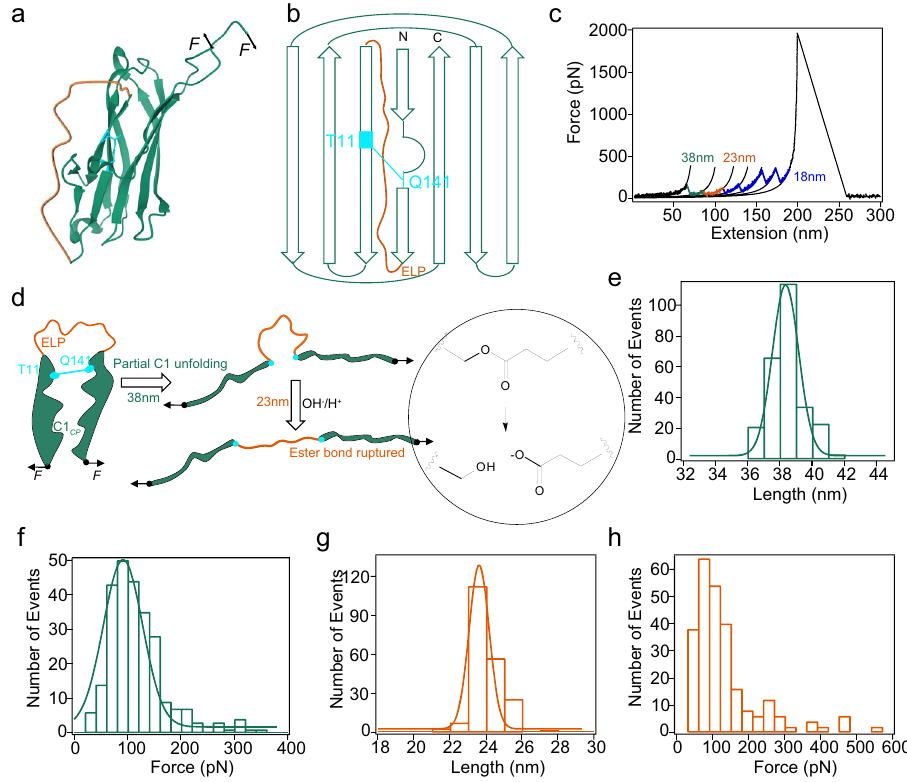
Fig. 3 Mechanical unfolding of the circular permutant of C1, C1 CP . a Structure of C1 CP based on PDB (4MKM). b Topology of C1 CP . Ester bond formed between T11 and Q141 is highlighted in cyan. The new N- and C-termini are at the position 126 and 125, respectively. The original N- and C-termini are connected by an ELP loop. c Representative force – extension curve of stretching (GB1) 2 -C1 CP -(GB1) 2 following the same experimental protocol shown in Fig. 1d. The force peaks with Δ L c of ~38 nm (green) and ~23 nm (orange) are assigned as the unfolding of C1 CP and the rupture of ester bond, respectively. The force peaks of Δ L c of ~18 nm correspond to the unfolding of GB1 domains. d Schematic illustration of the contour length change upon stretching C1 CP . First, the protein unfolds up to the ester bond position, then the rupture of ester bond releases the sequestered sequence. e Histogram of Δ L c for C1 CP unfolding events peaks at 38 nm. f Unfolding force histogram of C1 CP centers at 91.5 ± 52 pN ( n = 243, total number of C1 unfolding events). The Monte Carlo simulation of the force distribution results in a Δ x u of 0.25 nm and α 0 of 0.37 s − 1 (Supplementary Fig. 14). g Histogram of Δ L c corresponding to the rupture of ester bond in C1 CP peaks at 23 nm. h Histogram of the rupture forces of ester bond centers at 77 ± 56 pN ( n = 243, total number of rupture of ester bond events). This experiment was repeated three times independently with similar results. Source data are provided as a Source Data fi